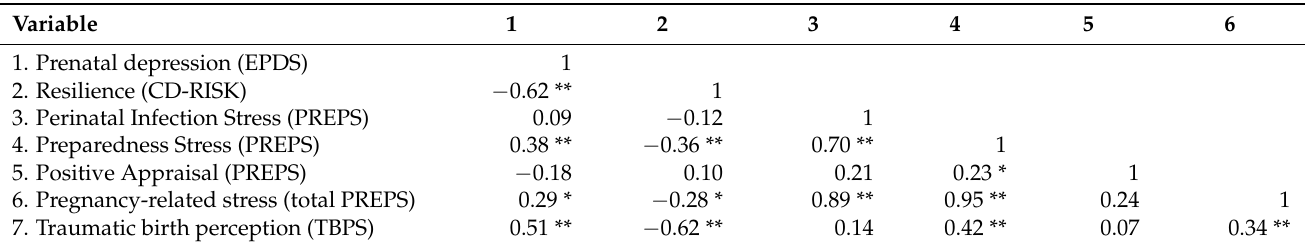
Table 5. Correlation matrix for the variables in the mediation model